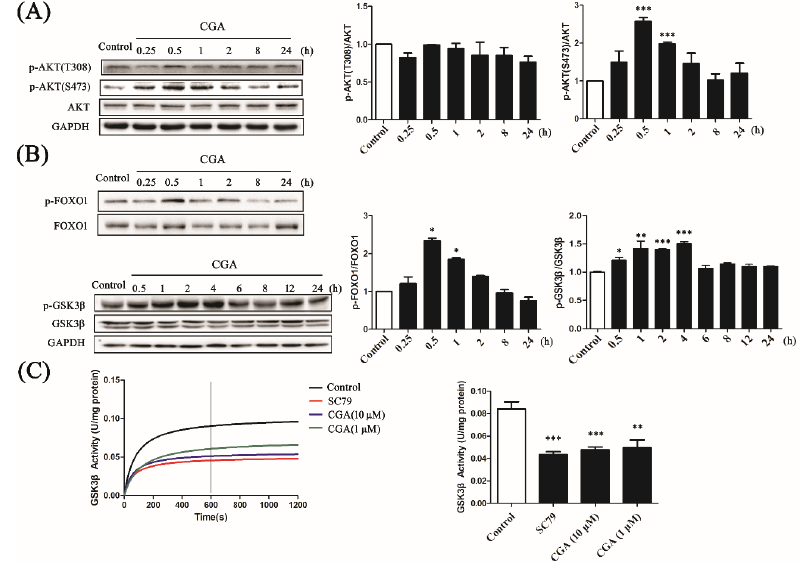
Figure 4. The effects of CGA on AKT phosphorylation and its downstream factors. ( A ) The time-dependent effect of CGA on the phosphorylation of AKT (T308 and S473). ( B ) The time-dependent effect of CGA on the phosphorylation of forkhead box O1 (FOXO1) and glycogen synthase kinase 3β (GSK3β). The histograms present the relative intensities of the detected protein bands. ( C ) The effect of CGA on the enzymatic activity of GSK3β. SC79 was used as the positive control. The histogram presents the activity of GSK3β at 600 s after the respective treatments. Each bar represents the mean ± SEM. * p < 0.05 vs. control; ** p < 0.01 vs. control; *** p < 0.001 vs. control ( n = 3).